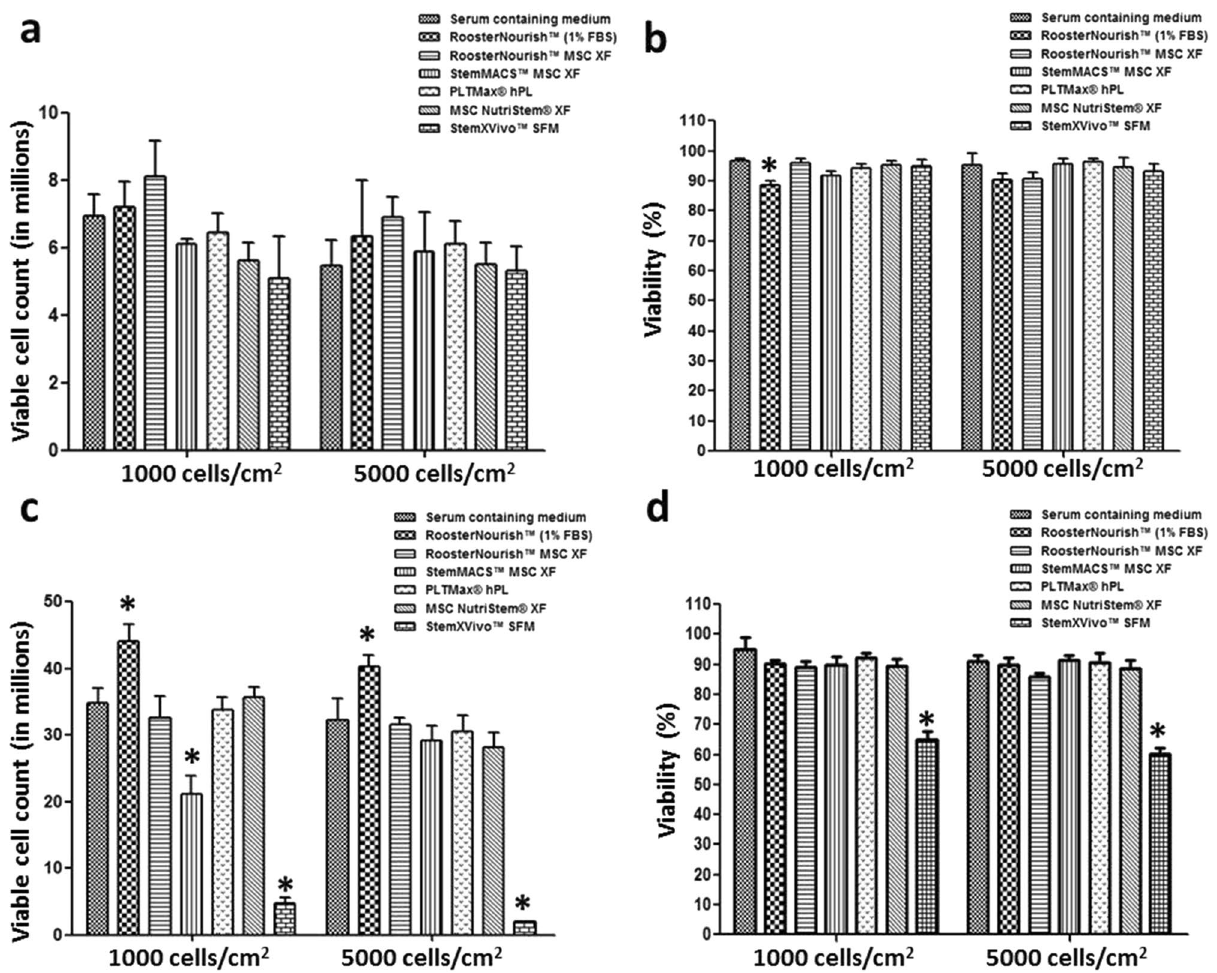
Figure 3. Comparison of yield and viability of BM-MSCs in six different low serum/SFM/XFM and control medium expanded at P4 (a & b) and P5 (c & d) . BM-MSCs were cultured in respective medium with two different seeding densities (1000 and 5000 cells/cm 2 ). Each of the medium tested supported the growth of MSCs at P4 in both the seeding densities and the cell yield and viability was comparable with control medium (a & b) . Except StemXVivo SFM, all other medium tested supported the growth of MSCs in subsequent passage (P5). The yield and viability of BM-MSCs cultured in low serum/SFM/XFM was comparable with control medium at P5. (c & d) . Experiments were performed in duplicates. The data is represented as mean ± SD, *p <